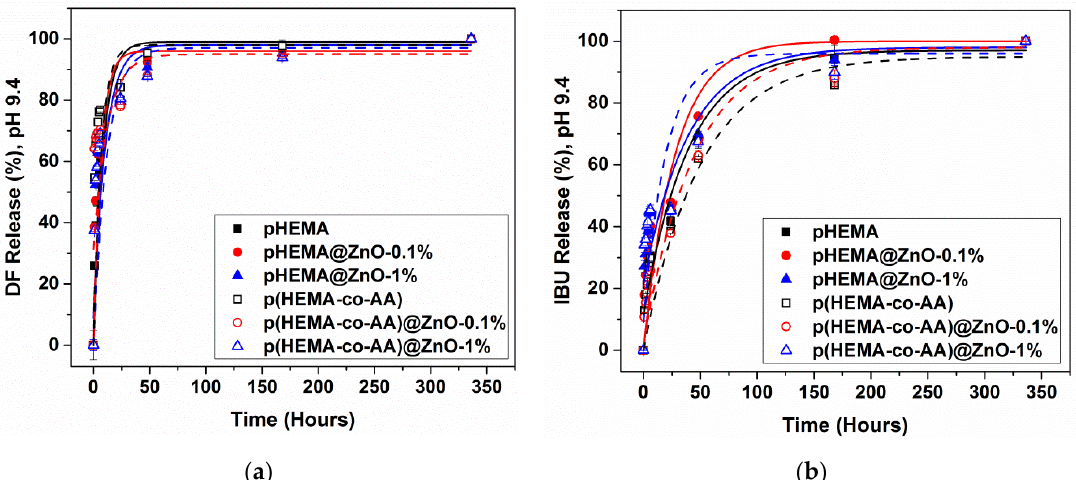
Figure 10. Kinetic of drug release during time, in alkaline artificial urine solution: ( a ) diclofenac and ( b ) ibuprofen, both in sodium salts form. Experimental points are reported along with their error bars. All of the experimental points follow a pseudo first-order kinetic law. Fitting curves are represented by plain lines for polyHEMA-based samples and by dashed lines for poly(HEMA-co-AA)-based samples. Table 3. Kinetic parameters for DF and IBU drug release at alkaline pH conditions.